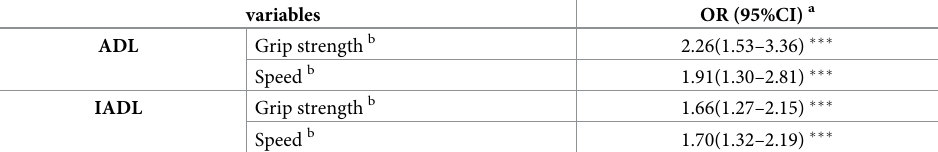
CI, confidence interval; OR, odds ratio; IADL, instrumental activities of daily living; ADL, activities of daily living. a. Hukou, age, gender, marital status, education level, BMI, social and physical activity frequency, comorbidity condition, handgrip strength and gait speed were controlled in in Model. b. Table 2. All analyses were conducted at a 5% significance level. Statistical thresholds: ��� p-value <